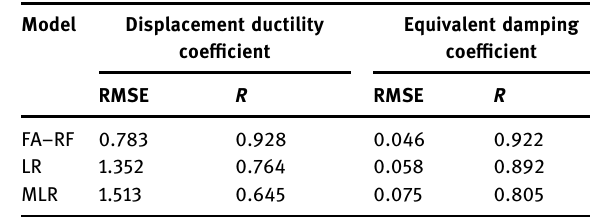
Table 10: Evaluation of displacement ductility coe ffi cient